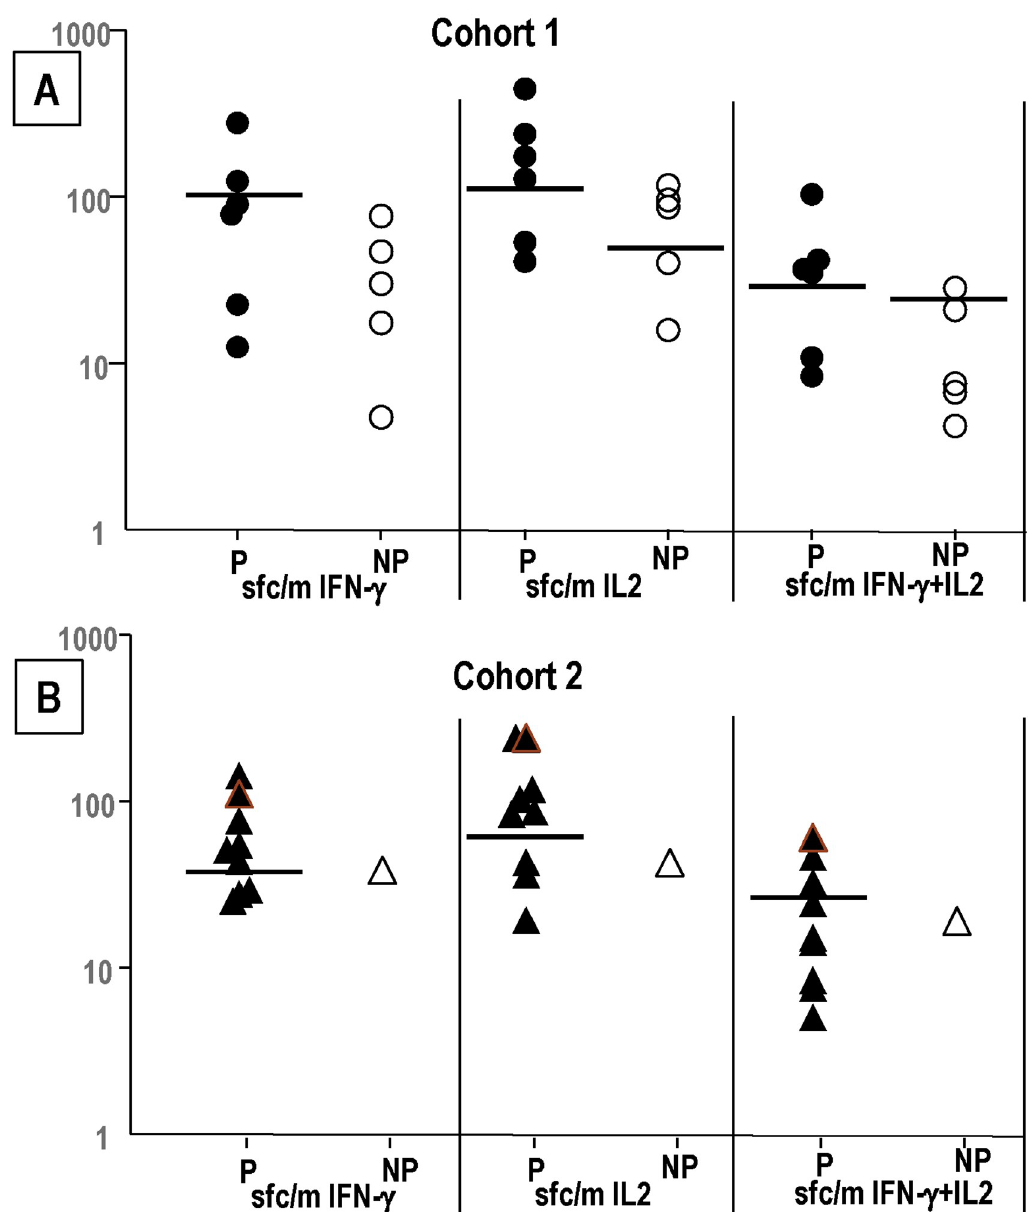
Fig 3. Cohort 1 and Cohort 2: Comparison of post-5 th (pre-CHMI) IFN- γ , IL2 and IFN- γ +IL2 responses to SPZ. Cohort 1: protected (n = 6), non-protected (n = 5); Cohort 2: protected (n = 9), non-protected (n = 1). Post-5 th (pre-CHMI) Cohort 1 and Cohort 2 IFN- γ , IL2 and IFN- γ +IL2 responses to SPZ of each subject are protected (P) or not protected (NP) to CHMI#1. Horizontal black lines separate subjects with positive (above) or negative (below) responses. Panel A: Cohort 1: numbers of protected subjects with higher activities than the highest responding non-protected subject were: IFN- γ (2/6), IL2 (4/6) and IFN- γ +IL2 (4/6). Panel B: Cohort 2: numbers of protected subjects with higher activities than the highest responding non-protected subject were: IFN- γ (6/9), IL2 (6/9) and IFN- γ +IL2